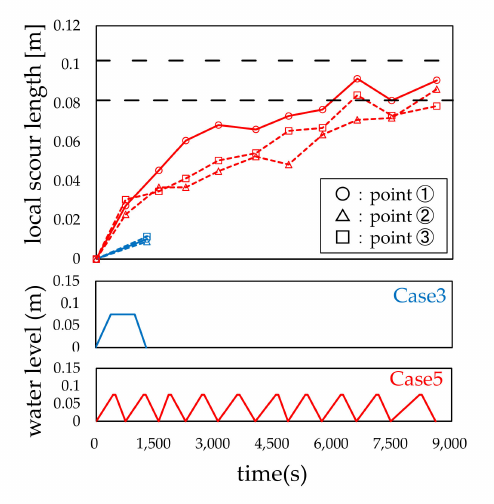
Figure 14. Local scour length of Cases 3 and